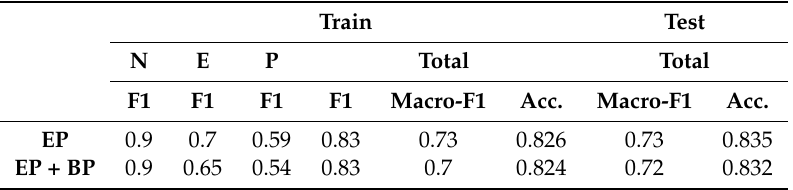
Table 5. Evaluation results for each evaluation scenario of the multi-class setting. Train